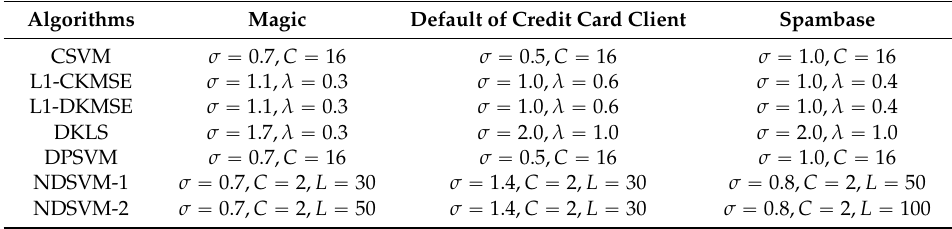
Table 2. Values of the parameters of the algorithms on the UCI datasets. CSVM, Centralized